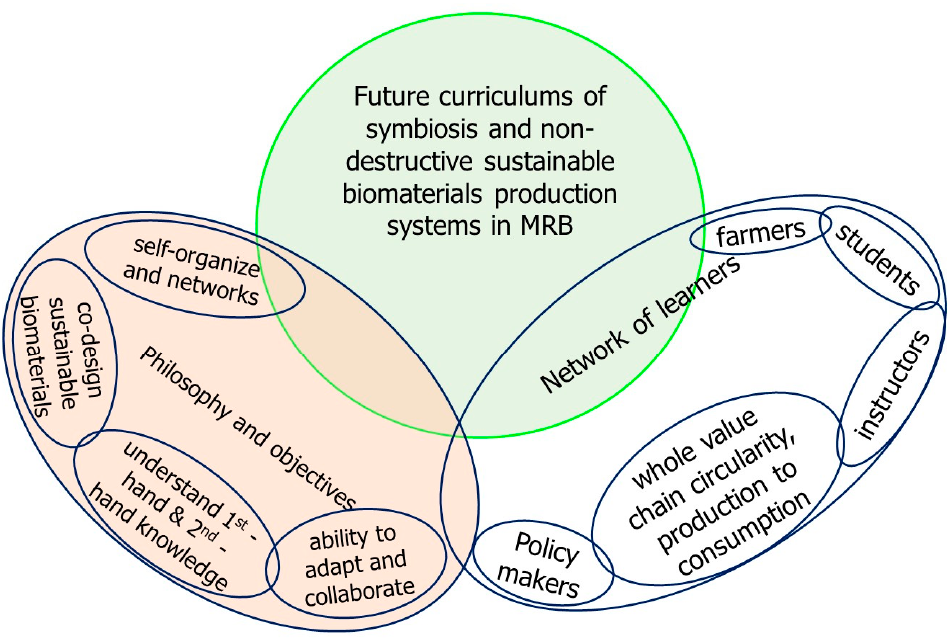
Figure 2. Key components of the symbiosis and non-destructive sustainable biomaterials production systems curriculum in MRB.